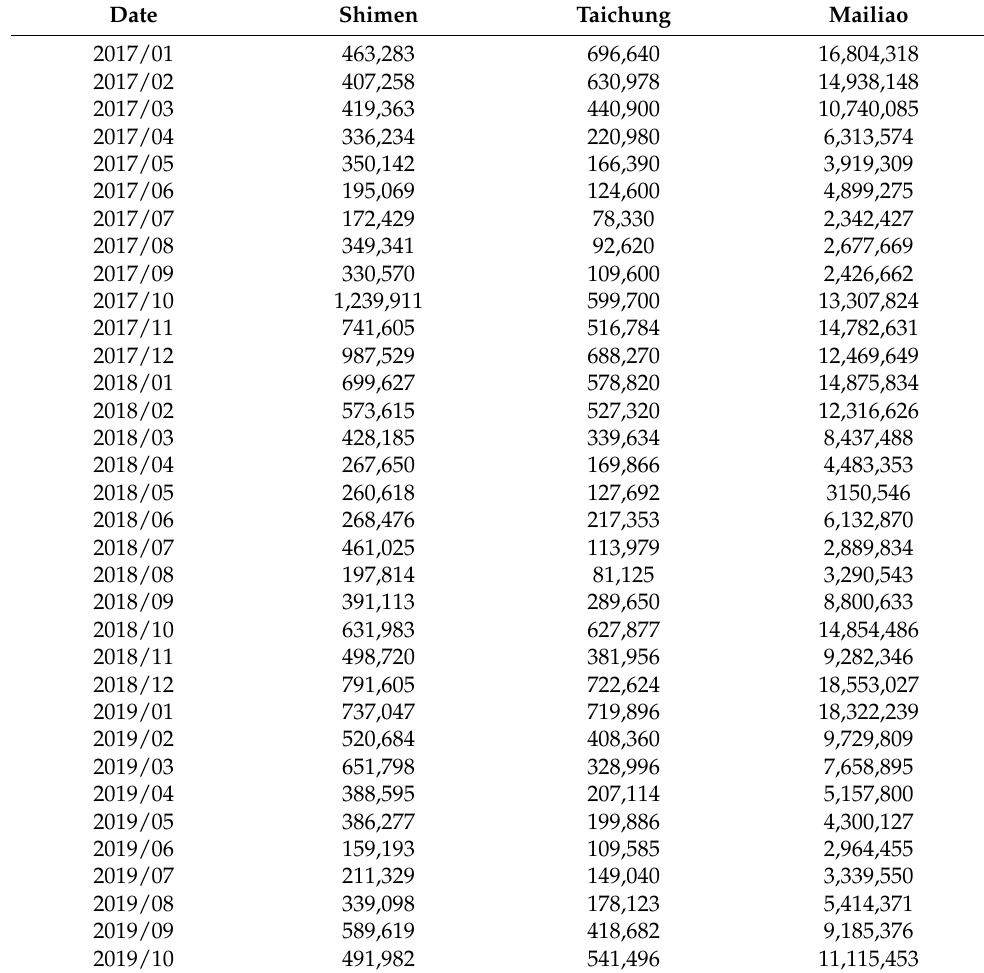
Figure 3. Illustration of the actual power output of the three wind power stations. Table 2. The actual power output of the three wind power stations ( units: kilowatt-hours ).